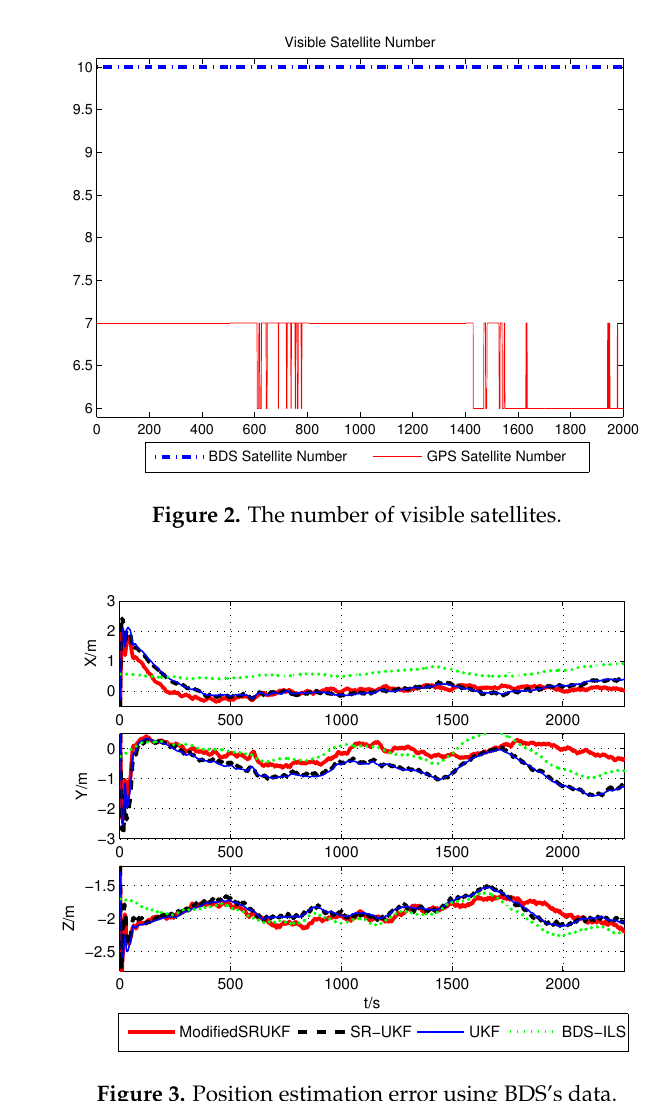
Figure 3. Position estimation error using BDS’s data.